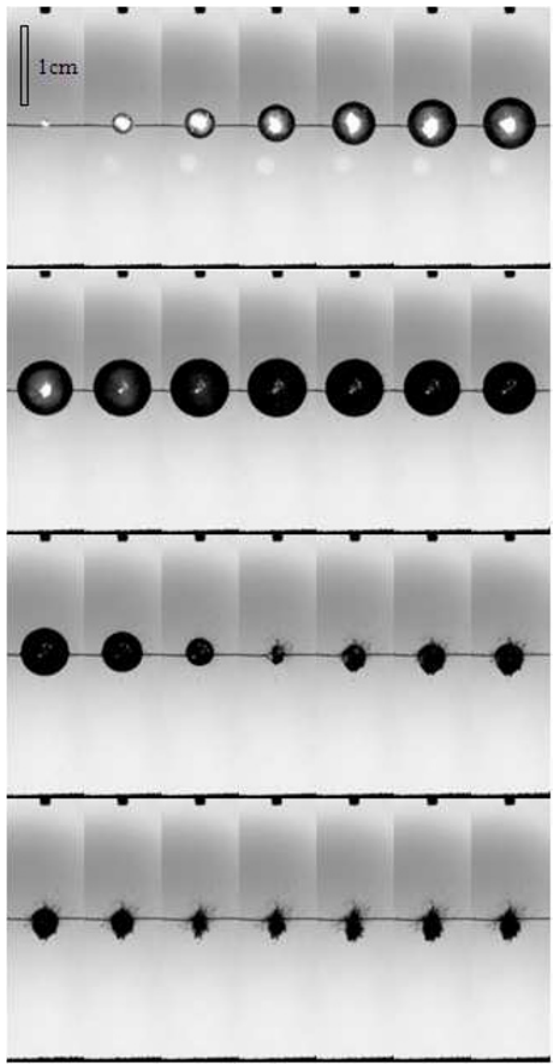
Fig. 3. Collapse pattern 1 – high-speed camera record. Time distance between the frames is 62.5 µ s.